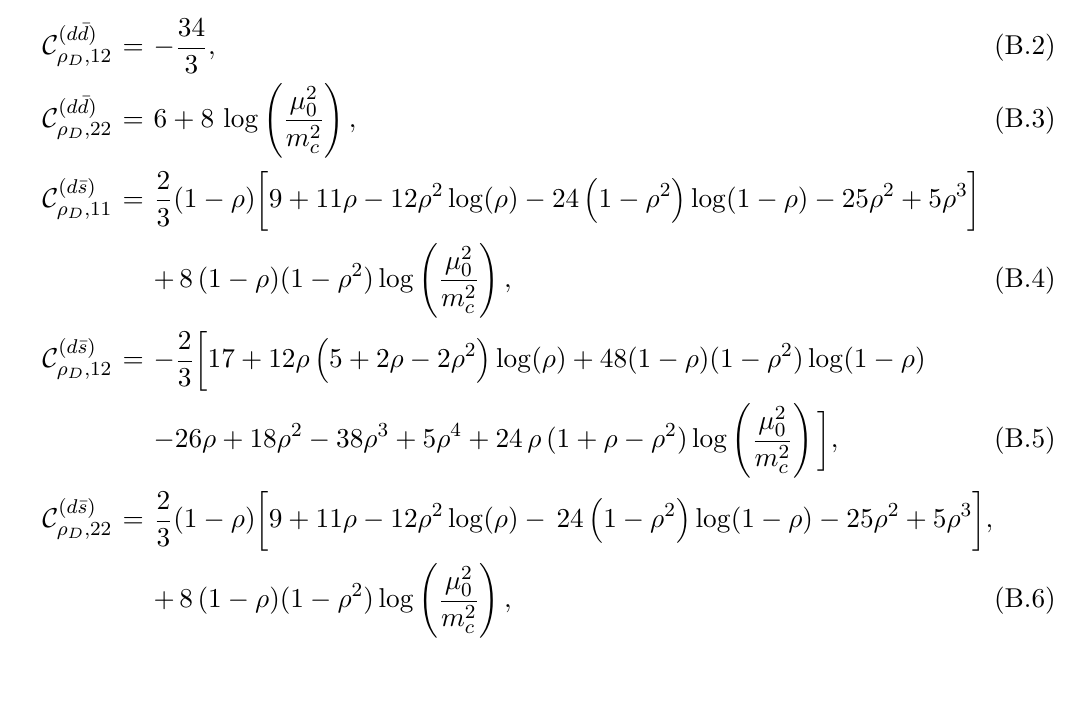
Table 17 . Numerical values of the HQET Bag parameters [66, 68] evaluated through a traditional HQET sum